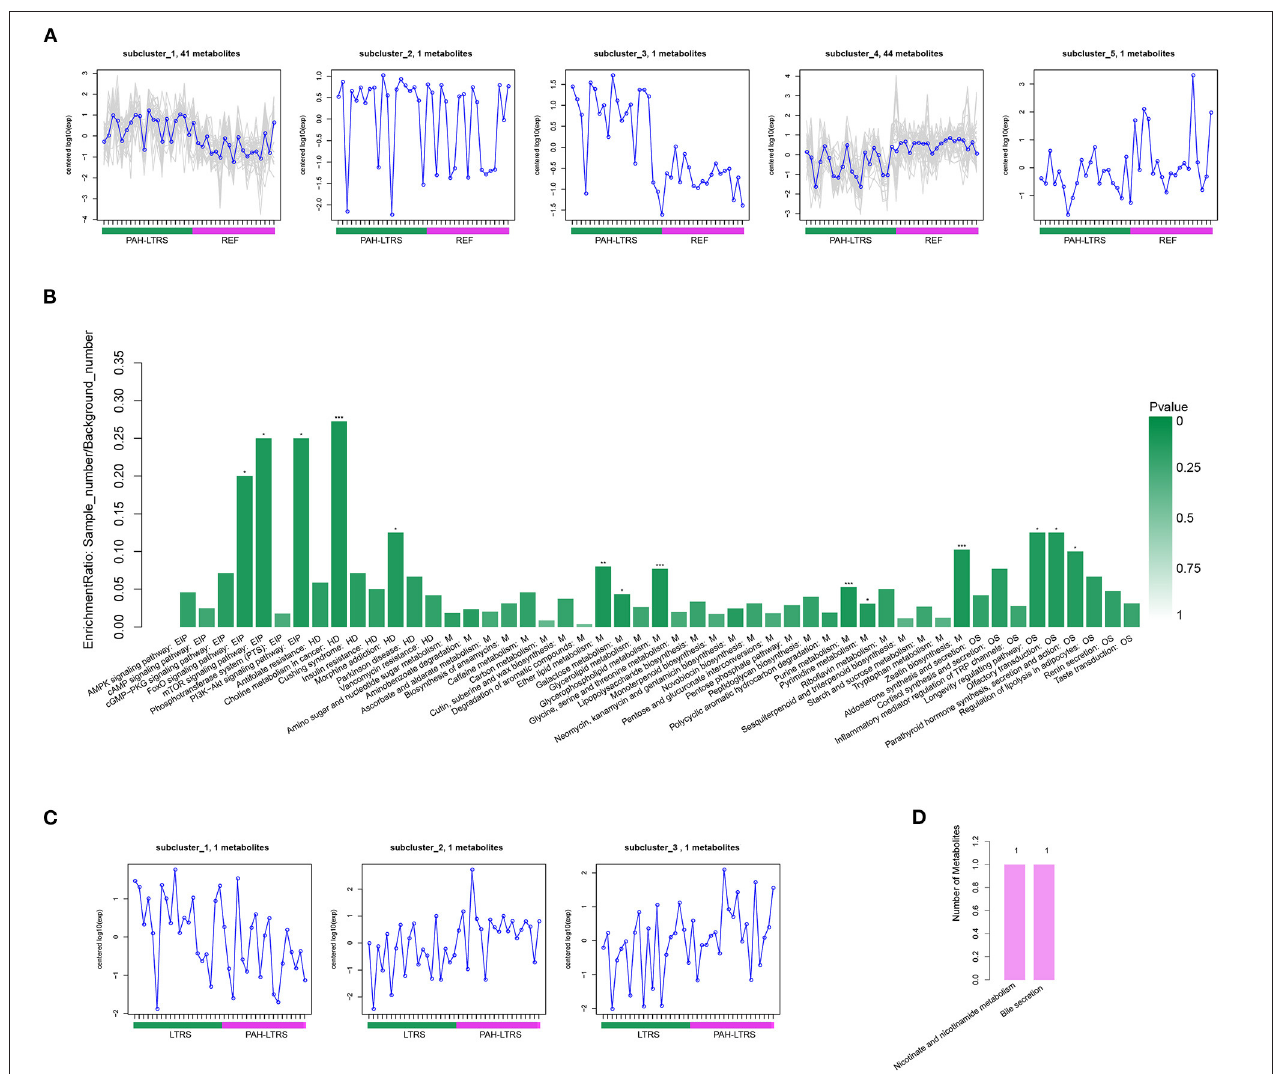
FIGURE 5 | Differential metabolites clustering and KEGG enrichment. (A) Differential metabolites in REF vs. PAH-LTRS were clustered into 5 clusters. These sub-clusters had different expression trend in two groups. (B) KEGG enrichment of these differential metabolites in REF vs. PAH. (C) Three differential metabolites in LTRS vs. PAH-LTRS also shown with different abundance in two groups. (D) Three differential metabolites in LTRS vs. PAH-LTRS were annotated into two pathways without significantly enrichment. EIP, Environmental Information Processing; HD, Human Diseases; M, Metabolism; OS, Organismal Systems. PAH-LTRS, patients with pulmonary arterial hypertension associated with Left-to-Right shunt ( n = 19); REF, healthy reference ( n = 20); LTRS, patients with Left-to-Right shunts but without PAH ( n =